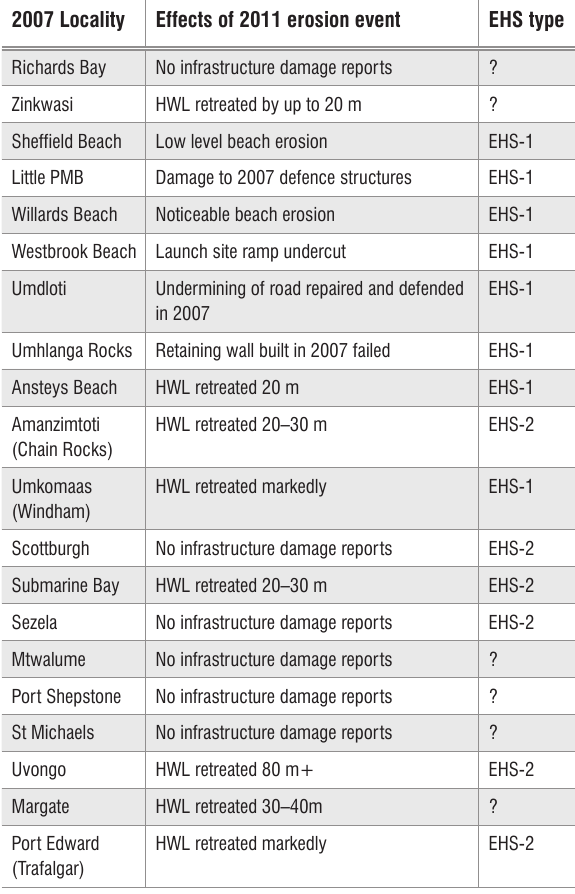
Table 1: Locality where coastal erosion occurred in 2007, effects of erosion in 2011 at the same localities and the type of erosion hotspot